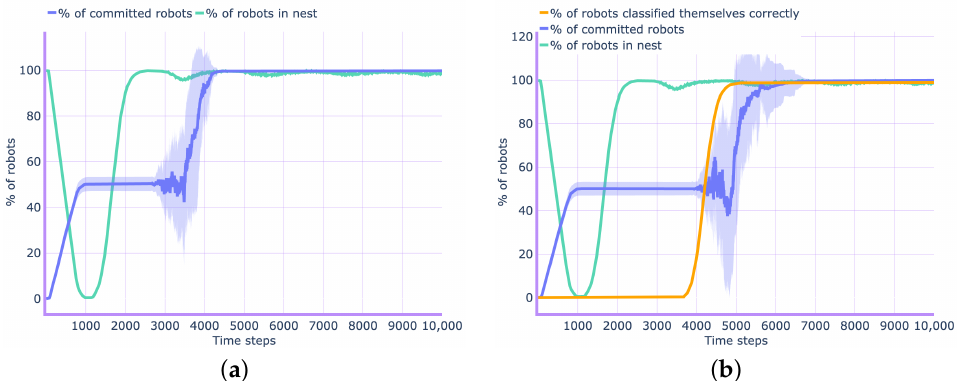
Figure 4. The emergence of the collective decision: ( a ) when robots follow the basic behavioral model and ( b ) when robots classify themselves using the distance-based algorithm. We simulate a swarm of 70 objective, 70 underestimating, and 70 overestimating robots. Errors in measurements can occur at site A (red)